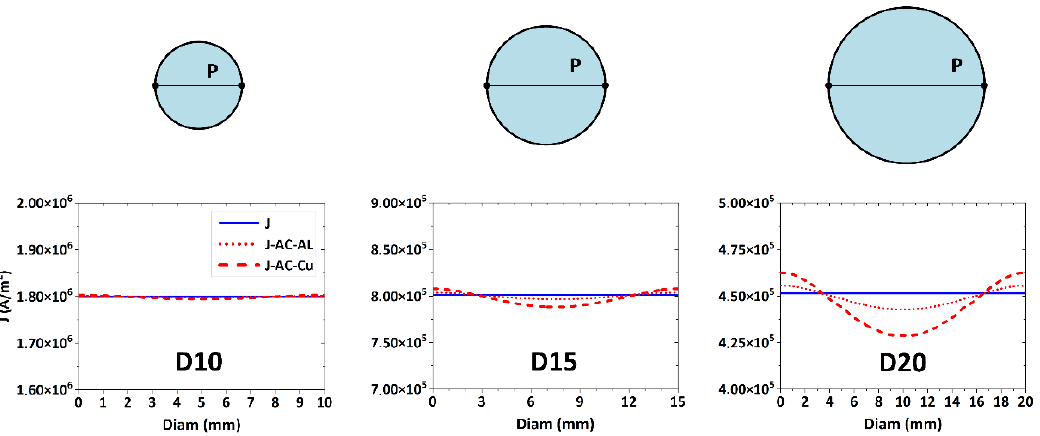
Figure 4. Numerically predicted distributions of current density across cross-sections of 20 mm, 15 mm, and 10 mm Al and Cu conductors.